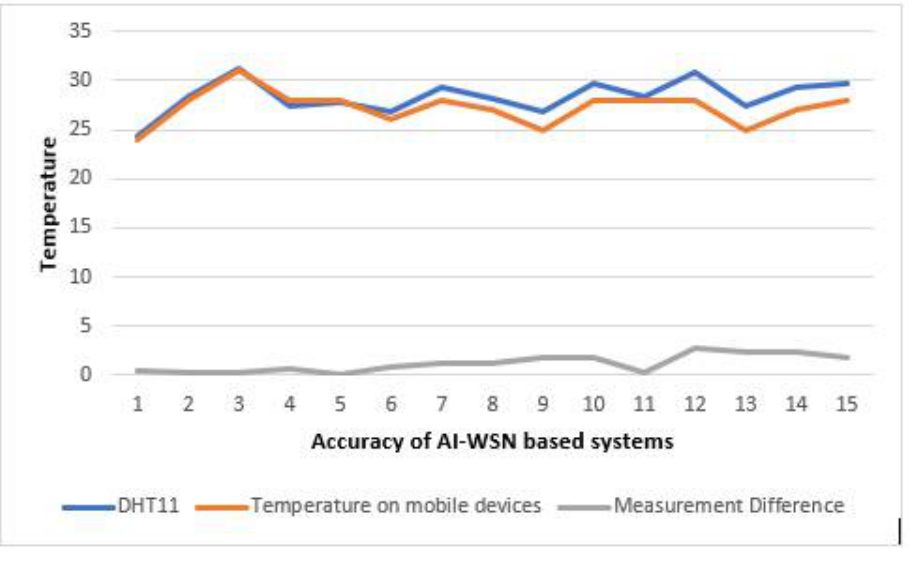
Figure 5. Impact of temperature on the accuracy of AI-WSN-based systems for fire preven- tion/monitoring [32].